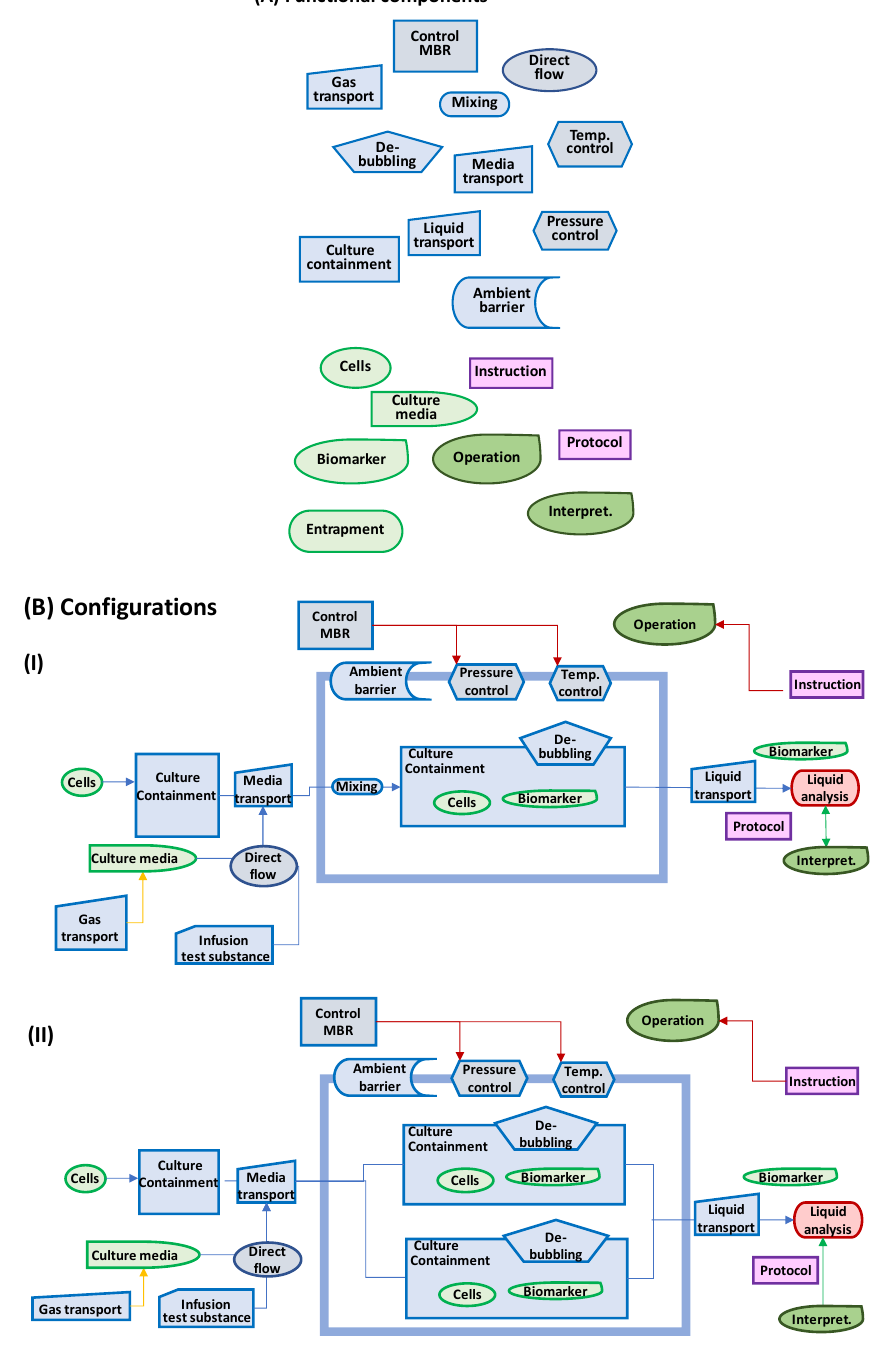
Figure 4. ( A ) Biological (green), technical (blue), and information (red) functional components required in an MBR device as identified from the functional subsystems in the HE-map in Figure 3; ( B ) Two examples of configurations from these functional components in which two MBR units are included in the prototype design.